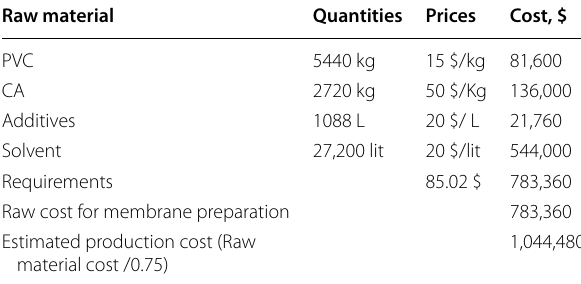
Table 7 Raw materials cost of blend (PVC/CA)